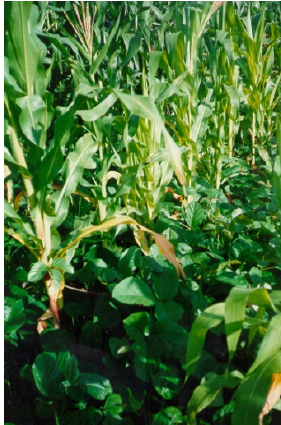
Figure 1. Maize intercropped with Canavalia ensiformis. The leguminous Canavalia fixes nitrogen which can be used by the cereal crop.